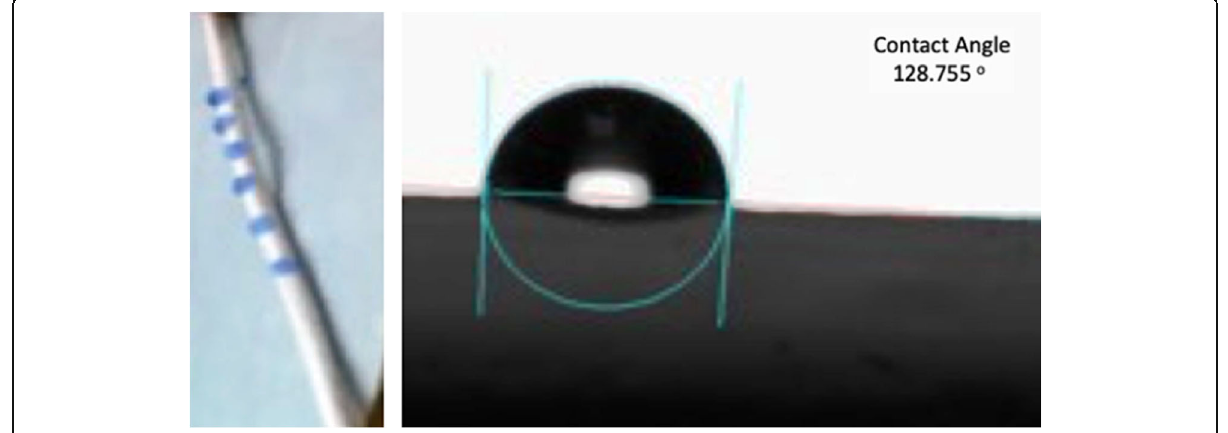
Fig. 18 Water contact angles of the PDVF membranes